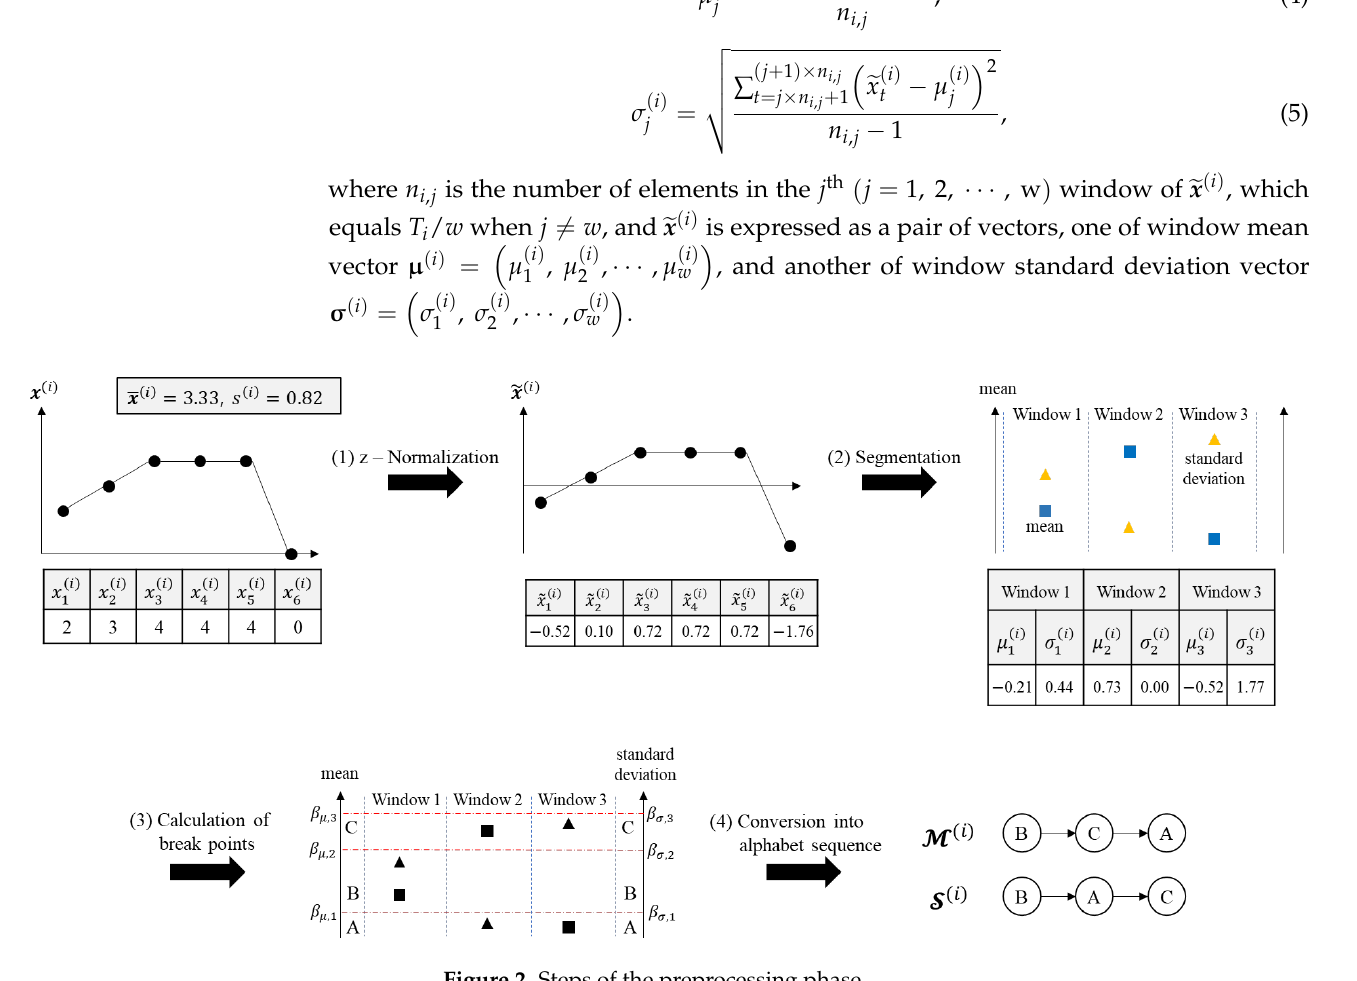
Figure 2. Steps of the preprocessing phase.